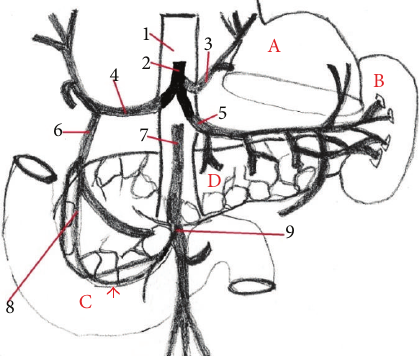
Figure 7: The division of the celiac trunk and the presence of the anastomosis between a. supraduodenalis superior and a. pancreati- coduodenalis inferior in human (anastomosis, arrow ) (scheme). 1: aorta abdominalis , 2: truncus ceoliacus , 3: a. gastrica sinistra , 4: a. hepatica communis , 5: a. splenica , 6: a. gastroduodenalis , 7: a. mesen- tericasuperior ,8: a.supraduodenalissuperior ,9: a.pancreaticoduode-